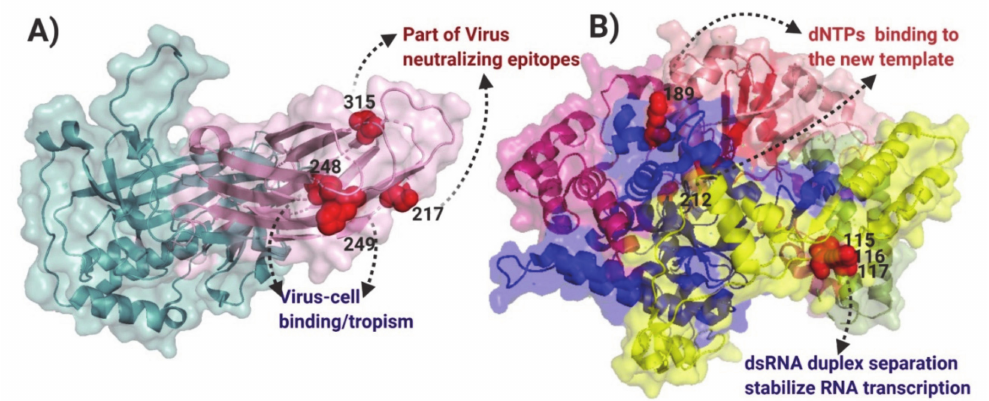
Figure 4. Mapping of positively selected sites and functional divergence sites on the three-dimensional structure of VP2 and VP1 of IBDV. ( A ) Folding of the monomer of the VP2 protein (PBD:2DF7); the shell domain is denoted in aqua and the HVR is denoted in light pink, positively selected sites identified by the site models M2a and M8 vs. M1 and M7, respectively (see Table S2), are denoted with red spheres, and the functional role for each position under positive selection is also denoted. ( B ) Folding of the monomer of the VP1 protein (PDB:2PGG); the N terminus domain is presented in yellow, the fingers domain is presented in blue, the palm is denoted in light red, the C terminal domain is presented in hot pink, the functional divergent selected sites are denoted by red spheres, and the functional role for each Type II functionally selected position is also